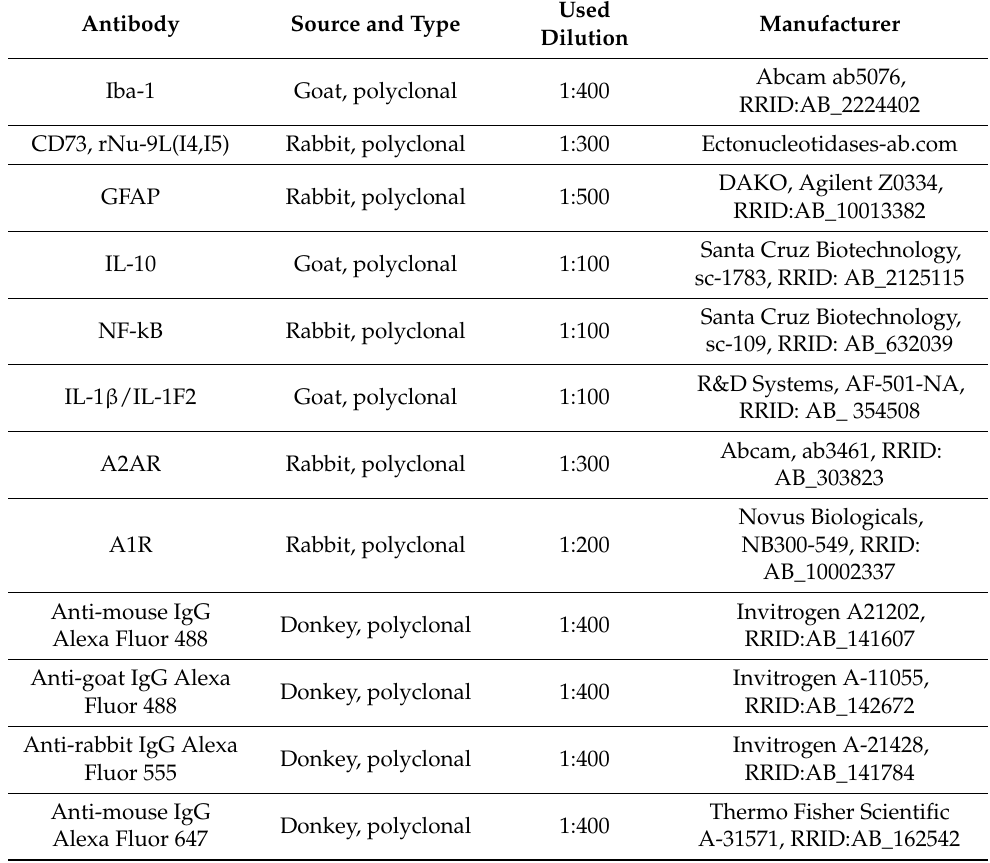
Table 1. Antibodies used for